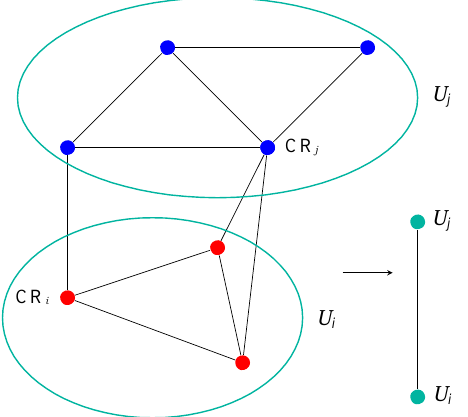
Figure 1. Graph partitioning and clustering. Two disjoint sets of nodes, U i (red) and U j (blue), form two nodes connected by a single pair of arcs in the simplified graph G 1 on the right. is d ∞ ( G, H ) = max v ∈ V ( G ) d G ( v, H ) , and should be as